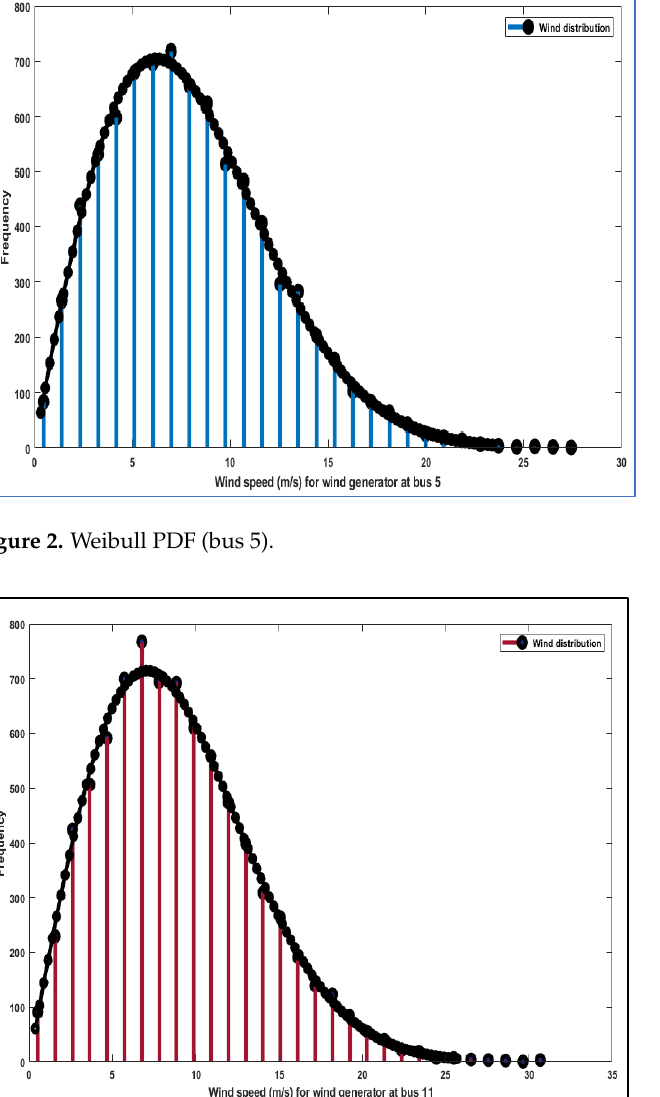
Figure 3. Weibull PDF (bus 11).